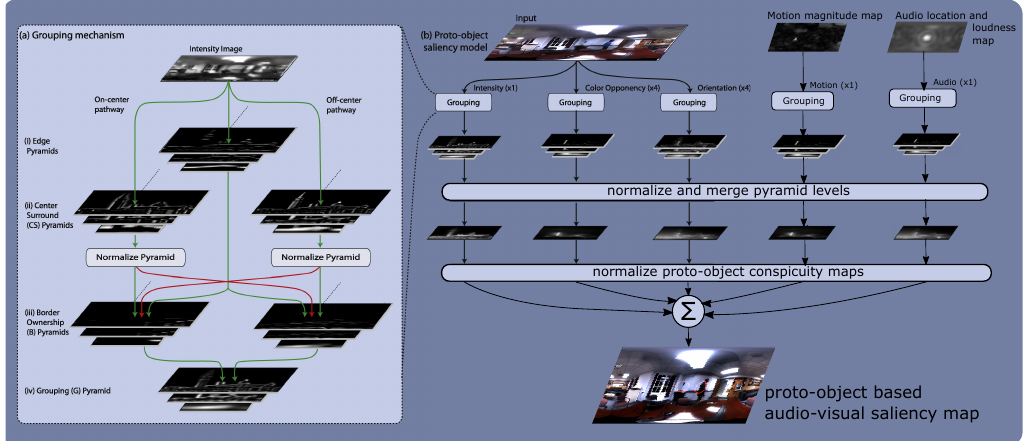
Figure 2. Computation of proto-object-based AVSM. ( a ) Grouping mechanism: At each scale, feature maps are filtered with center-surround cells, normalized, followed by border ownership (BO) computation. Grouping cells, at each scale, receive a higher feed-forward input from BO cells if they are consistent with Gestalt properties of convexity, proximity and surroundedness. Hence, grouping gathers conspicuous BO activity of features at object centers. Each feature channel undergoes same computation at various scales (except orientation, see explanation); only the intensity channel shown in ( a ). ( b ) Audiovisual saliency computation mechanism: Five feature types are considered: color, orientation, intensity and motion in the visual domain and spatial location and loudness estimate in the auditory domain. All features undergo grouping as explained in ( a ) to obtain proto-object pyramids. The proto-object pyramids are normalized, collapsed to get the feature specific conspicuity maps such that isolated strong activity is accentuated and distributed weak activity is suppressed. The conspicuity maps are then combined in different ways, as explained in Section 3.6, to get different saliency maps. Figure adapted with permission from